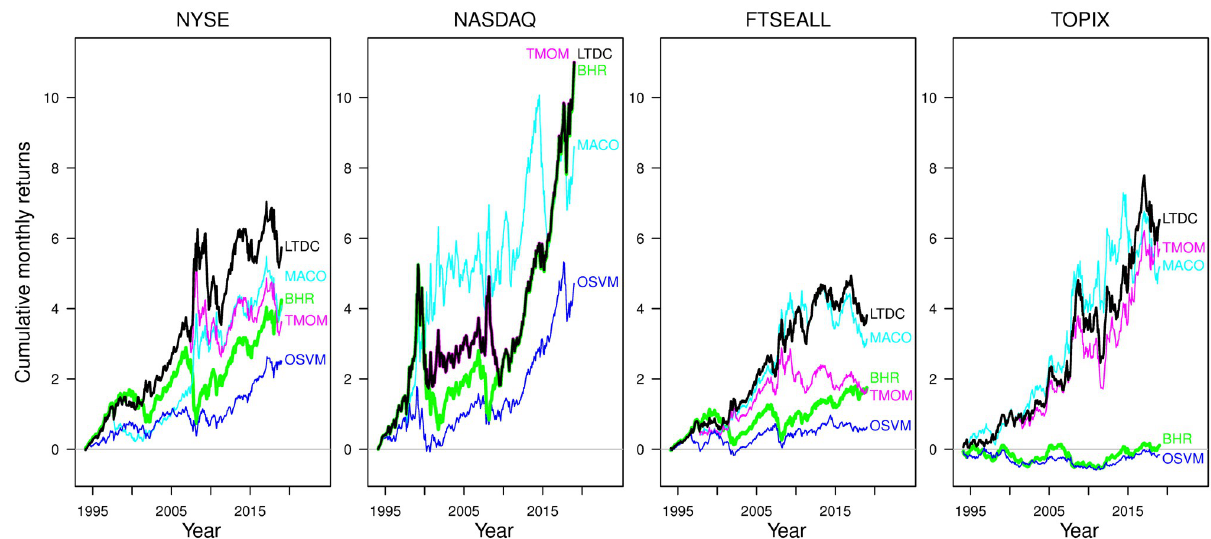
Fig 6. Evolution of cumulative monthly returns at the common optimum averaging window for all trend-following rules. The selected common optimum averaging window is d = 400 for NASDAQ, 200 for the NYSE and FTSEALL, and 100 for the TOPIX. L